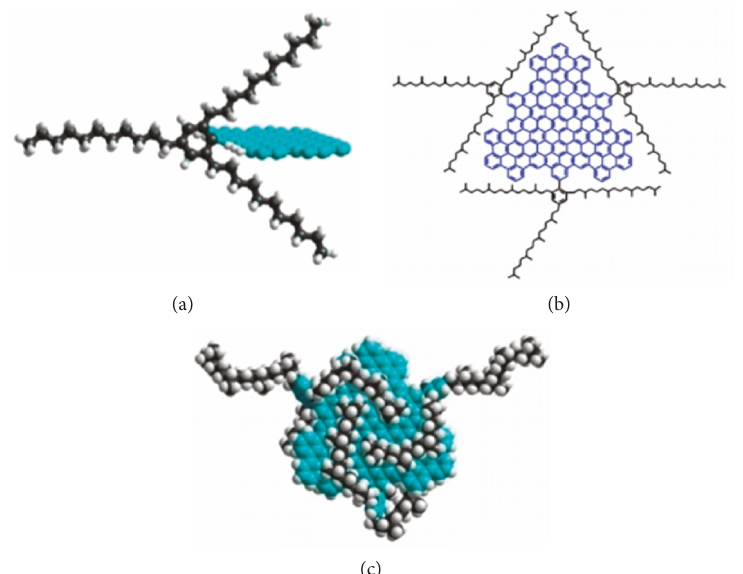
Figure 10: Strategy to make large graphene quantum dots soluble. (a) Attaching 1,3,5-trialkyl phenyl moieties (marked black) covalently to the edge of graphene (blue) to shield the graphenes from one another in three dimensions. Hydrogen atoms are marked white. (b) Molecular structure of graphene quantum dot 1, containing a graphene moiety with 168 conjugated carbon atoms. The graphene moiety is marked blue and the three solubilizing groups black. (c) A theoretically energy-minimized con fi guration of 1 in vacuum, showing the three-dimensional enclosure of the graphene core by the alkyl chains (black)